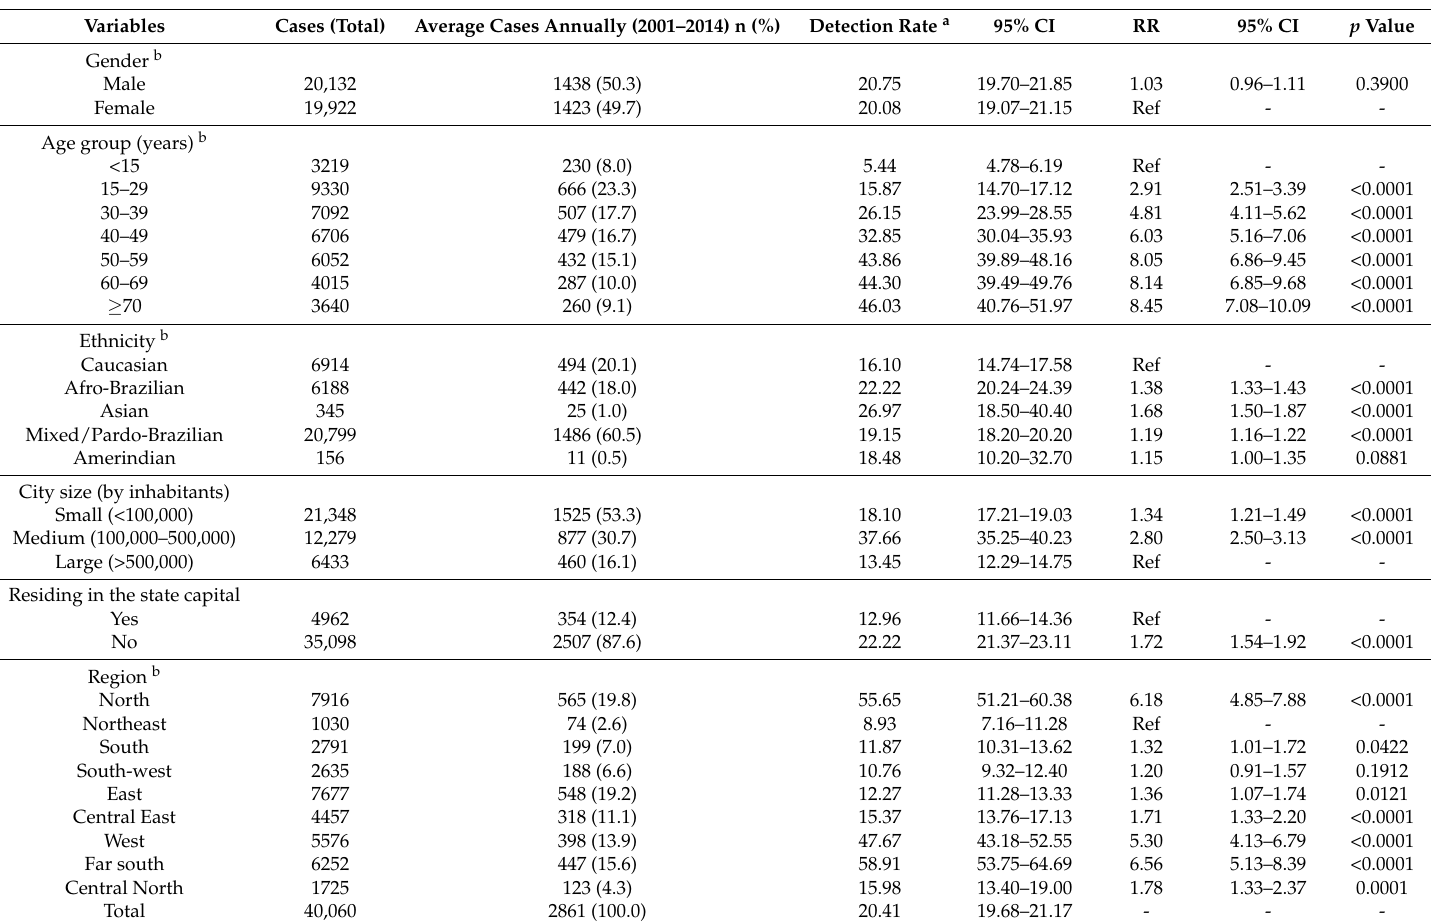
Table 1. Sociodemographic characteristics of leprosy cases and associated factors in Bahia state,